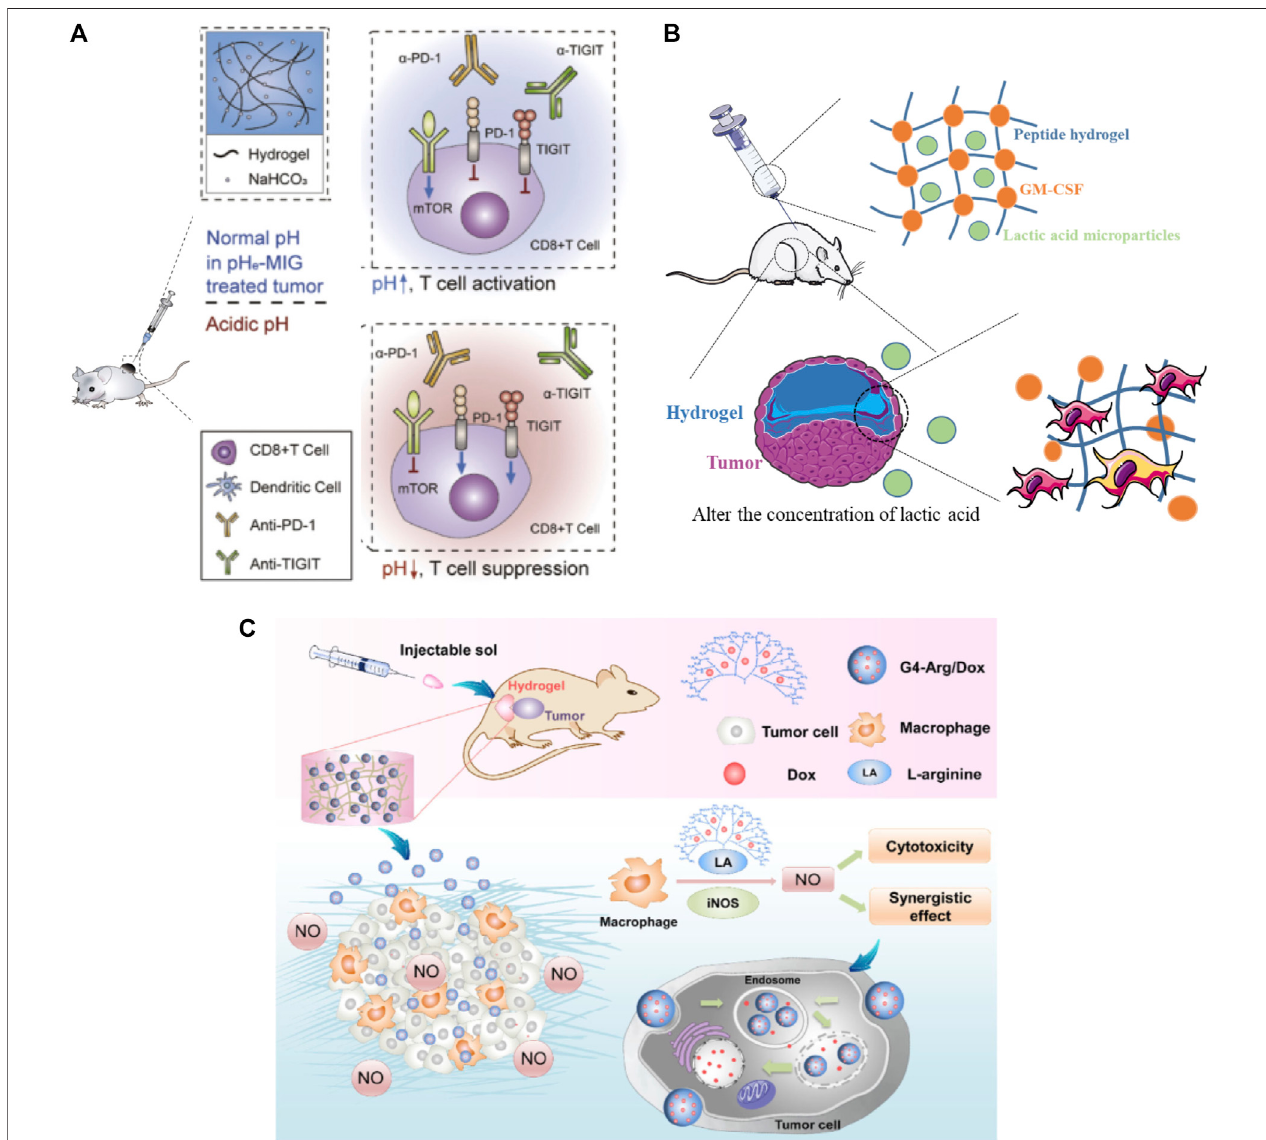
FIGURE5 | Hydrogels applied in thedeliveryofenvironmental regulatory substance. (A) Pluronic F-127 wasused asaNaHCO 3 releasingcarrier to focally alleviate extracellulartumoracidity.ReproducedwithpermissionJinetal.(2019).Copyright2019ElsevierLtd. (B) Alacticacid-producinghydrogelsystemwasdesigntochange the concentration of lactic acid at the tumor site to interrogate immune cell modulation in cancer-like environments. Reproduced with permission Allen et al. (2020). Copyright. 2020. The Royal Society of Chemistry. (C) A dendritic scaffolds were designed to enrich arginine molecules and provide the inducible nitric oxide synthase (iNOS) substrate, L-Arg, to M1 macrophages, which can produce the cytotoxic substance nitric oxide (NO) and subsequently induce tumor cell destruction through immunotherapy. Reproduced with permission Jiang et al. (2018). Copyright 2018 springer.